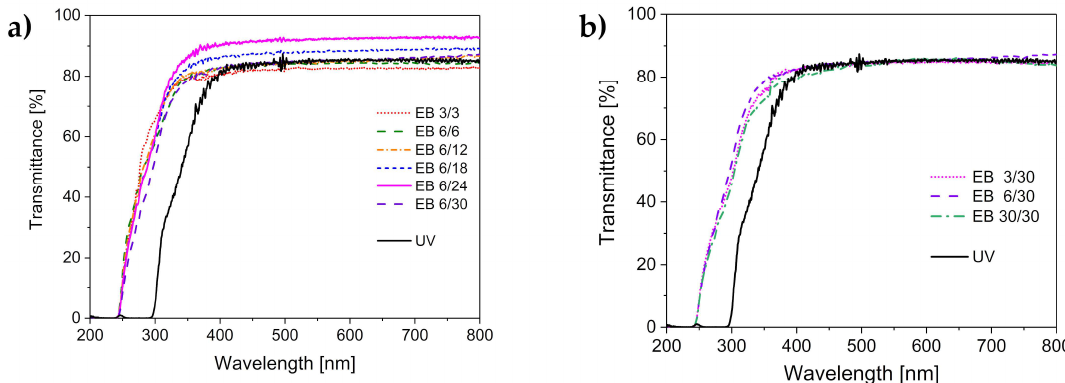
Figure 1. UV–Vis transmittance spectra of the UV-cured hydrogels compared to the hydrogels cured with electron beam (EB), with the variation of ( a ) the total doses and ( b ) the differential doses.